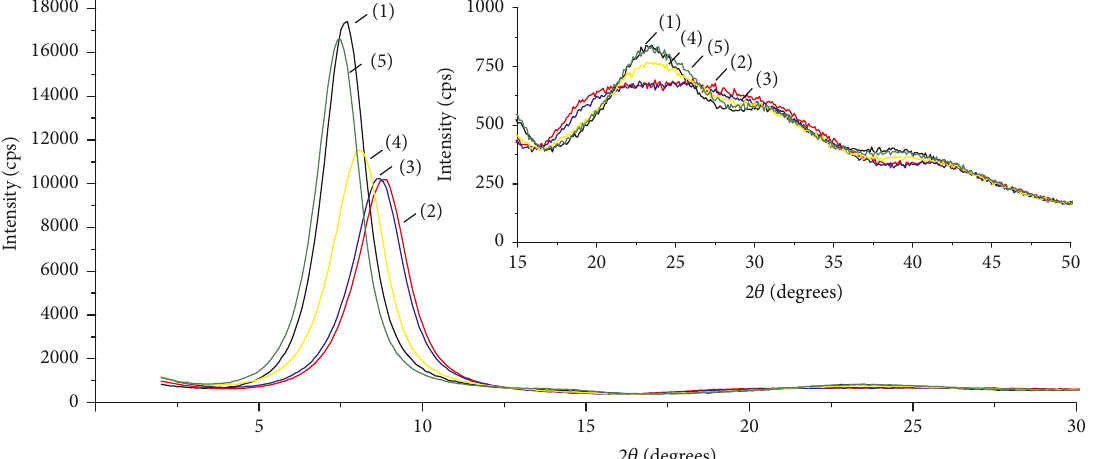
Figure 6: XRD patterns of V 2 O 5 gel film: (1) initial; (2) 1 hour after hydrogenation; (3) , (4) , and (5) after 1, 7, and 14 days,